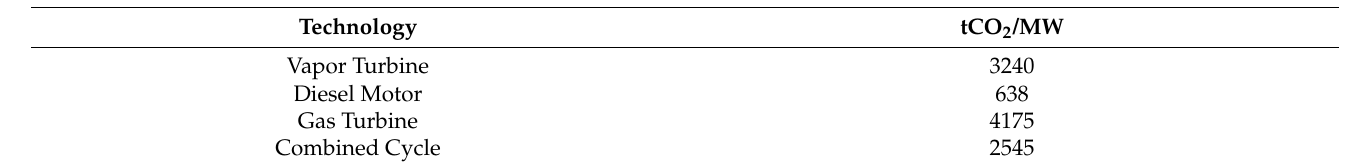
Table 9. Carbon footprint by installed power according to the technological structure of the generation park that uses oil products in the Canary Islands, broken down by islands (2017) [15].